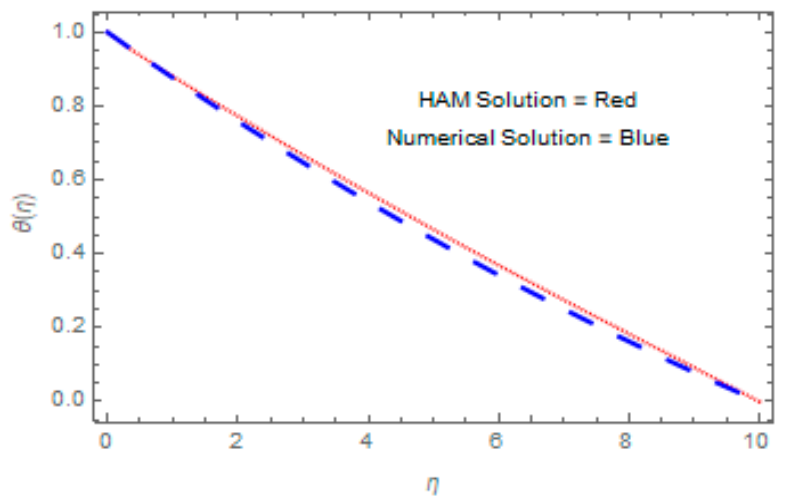
Figure 15. Comparison for platelet-shaped nanoparticles .